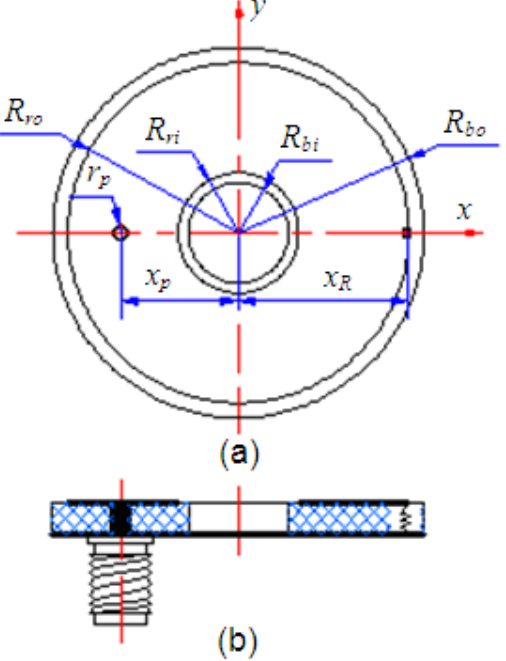
Figure 2. Configuration and parameters of the proposed antenna. ( a ) Top